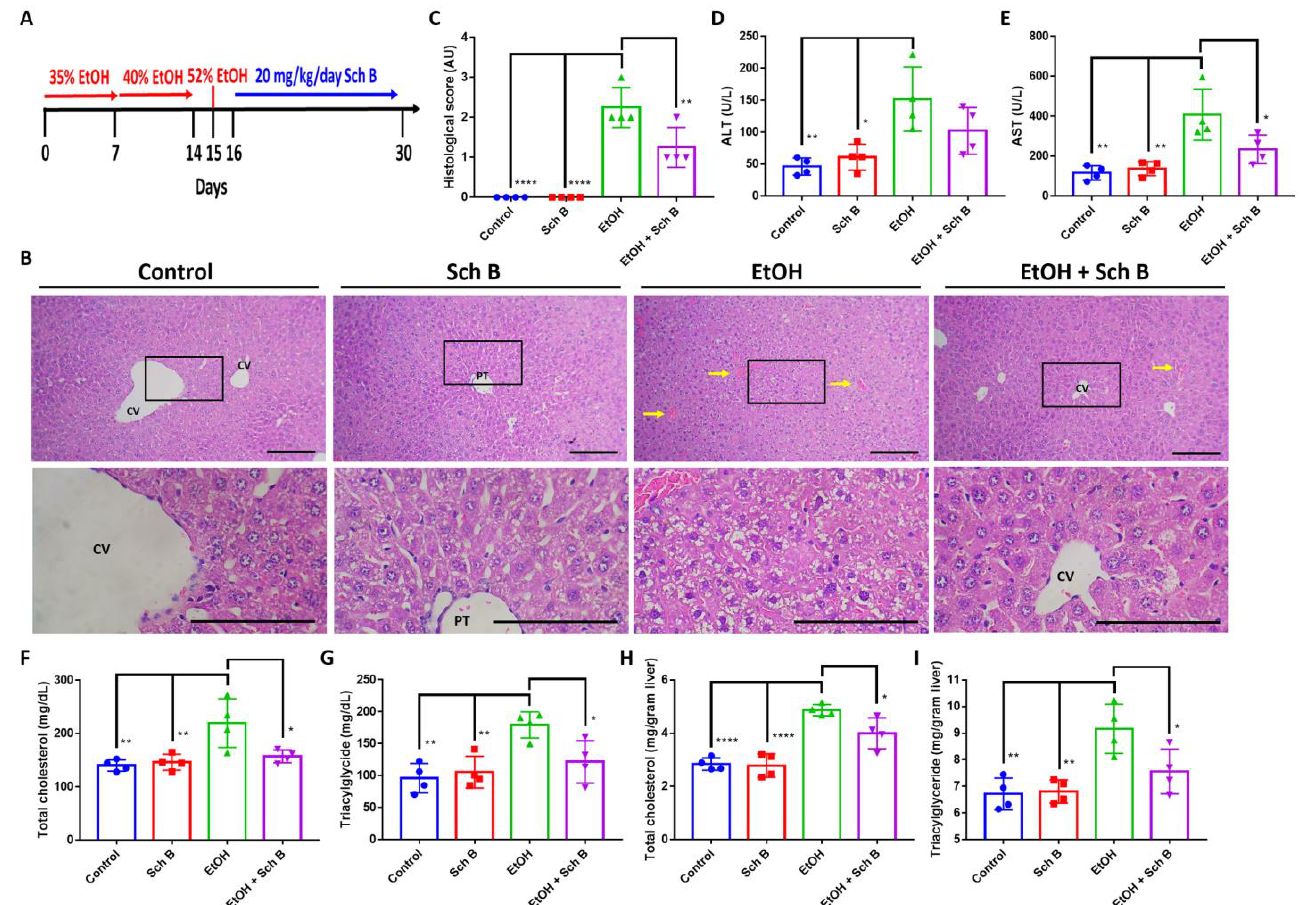
Figure 6. Schisandrin B alleviates ethanol-induced liver injuries in mice. ( A ) Experimental design scheme. ( B ) Representative H&E-stained histological images showing the liver pathology of the mice. Congestion (yellow arrows) and ballooning degeneration were seen in ethanol-treated mice, which were much improved by Sch B treatment. Scale bar corresponds to 200 μm. CV, central vein; PT, portal triad. ( C ) Histological scores based on the histological slides from ( B ). Serum levels of ( D ) ALT, ( E ) AST, ( F ) total cholesterol, and ( G ) triacylglycerides. Hepatic levels of ( H ) total cholesterol and ( I ) triacylglycerides. n = 4 mice. Results are expressed as mean ± SD. * p < 0.05, ** p < 0.01, and **** p < 0.0001.